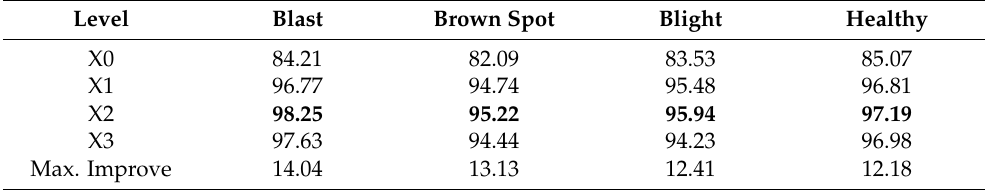
Table 9. The effect of the strength of data enhancement on the accuracy of the ResNet-50 model